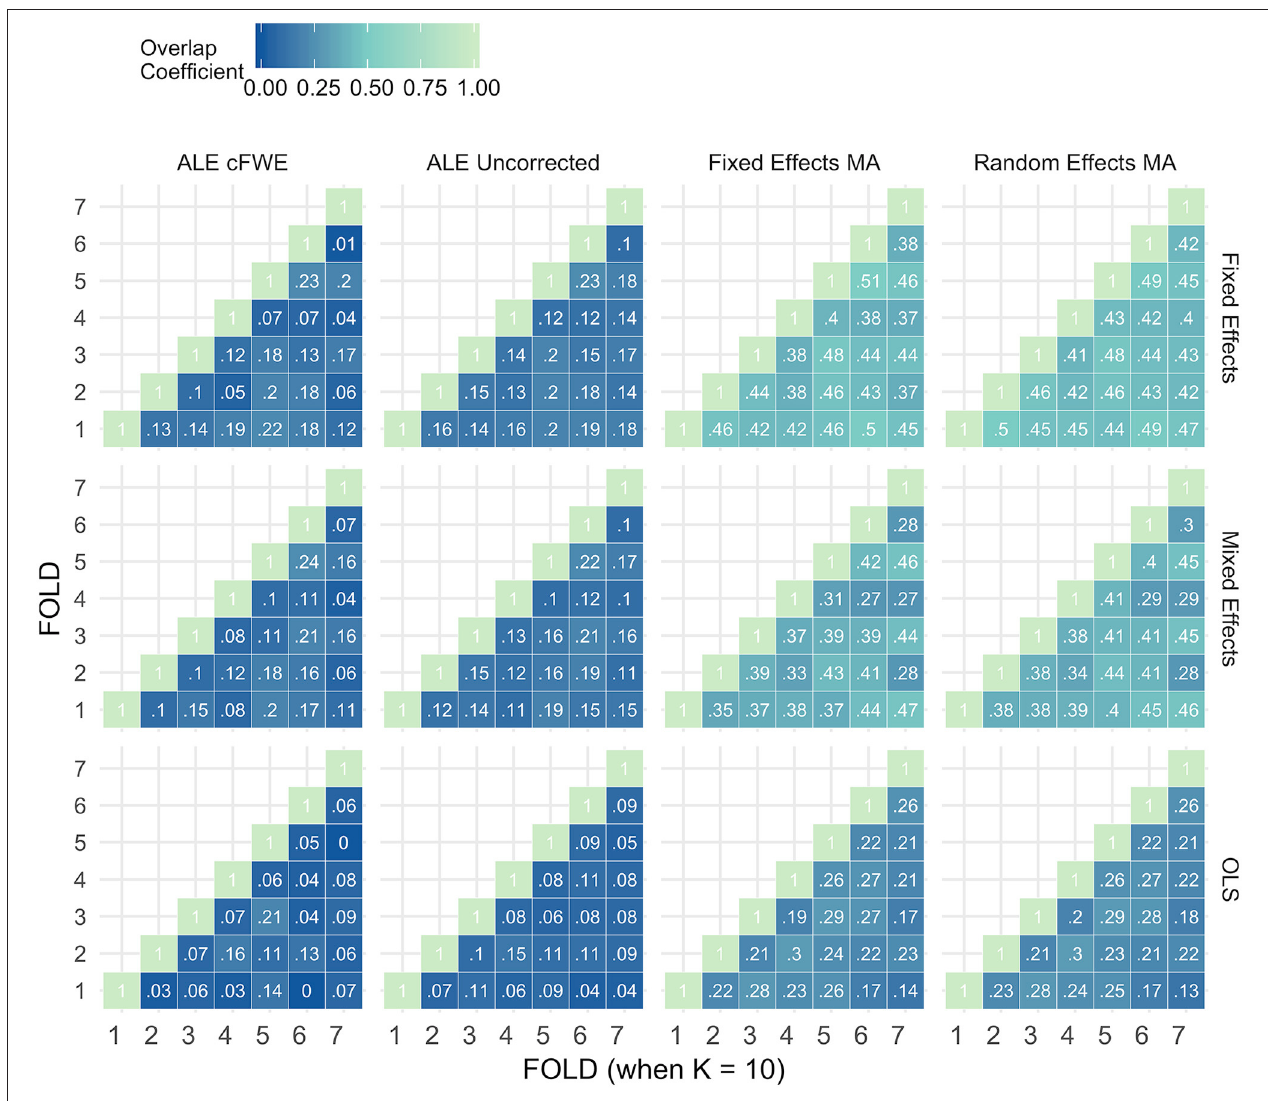
FIGURE 7 | Percent overlap of activation ( ω a , b ) from all pairwise comparisons for K mixed effects and OLS). The columns represent the thresholded meta-analyses. From left to right: ALE cFWE at 0.05, ALE uncorrected at 0.001 and fixed and random effects CBMA at 0.005 with Z >